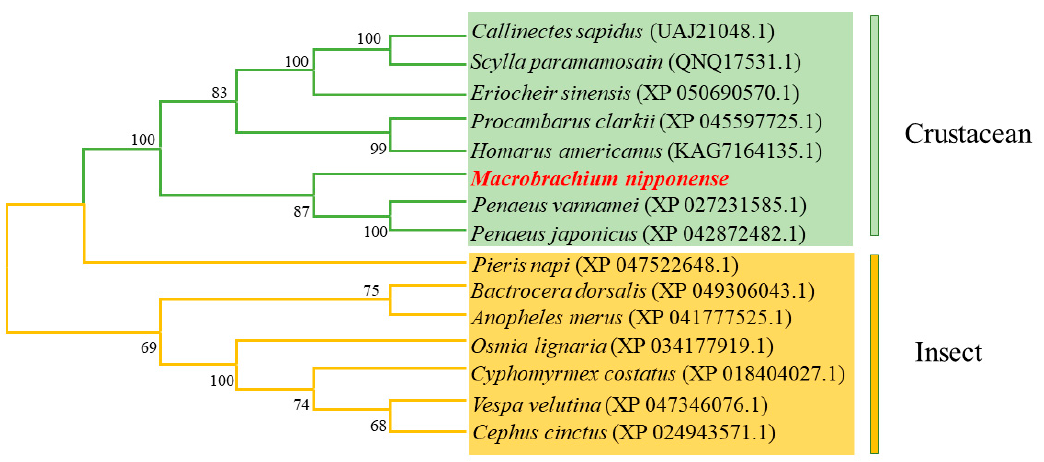
Figure 3. Phylogenetic tree connecting the Mn-CH7D amino acid sequence of Macrobrachium nip- ponense and other species. The numbers in brackets indicate the GenBank accession numbers. The numbers shown at the branches indicate the bootstrap values (%).